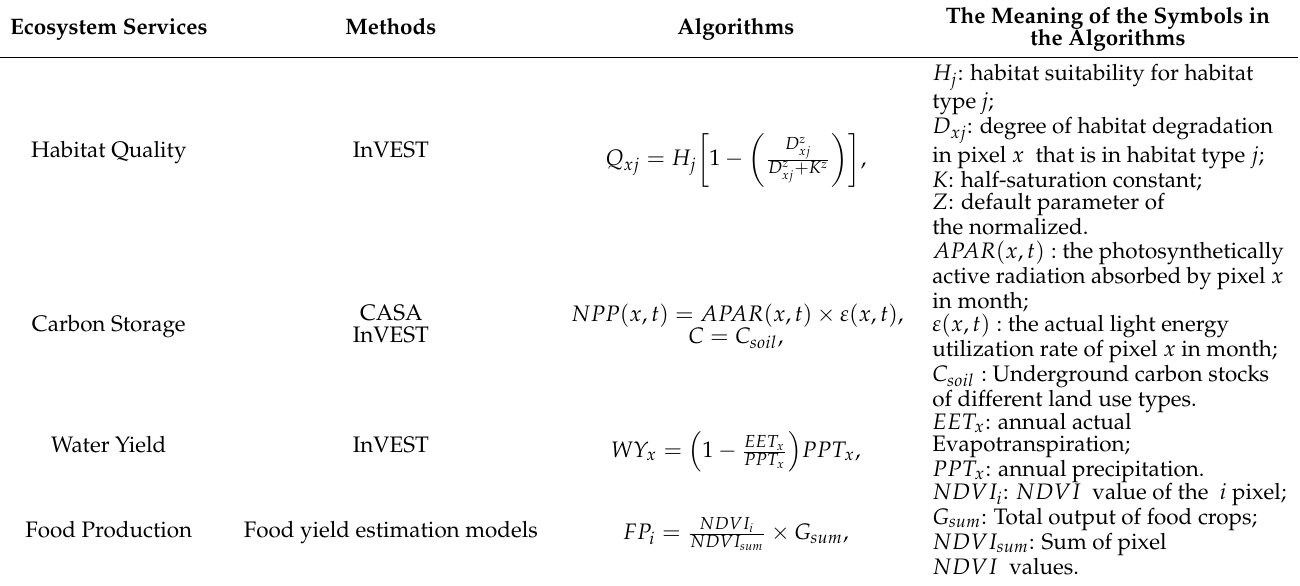
Table 1. Methods and main references for evaluating ecosystem